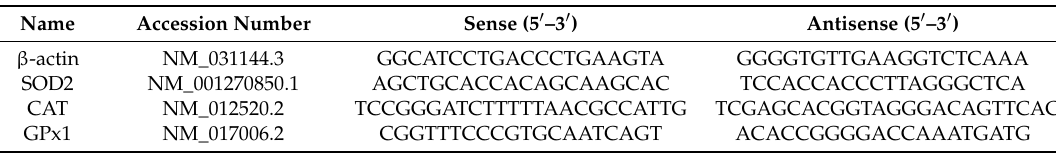
Table 1. Primer sequences of genes analyzed by real time